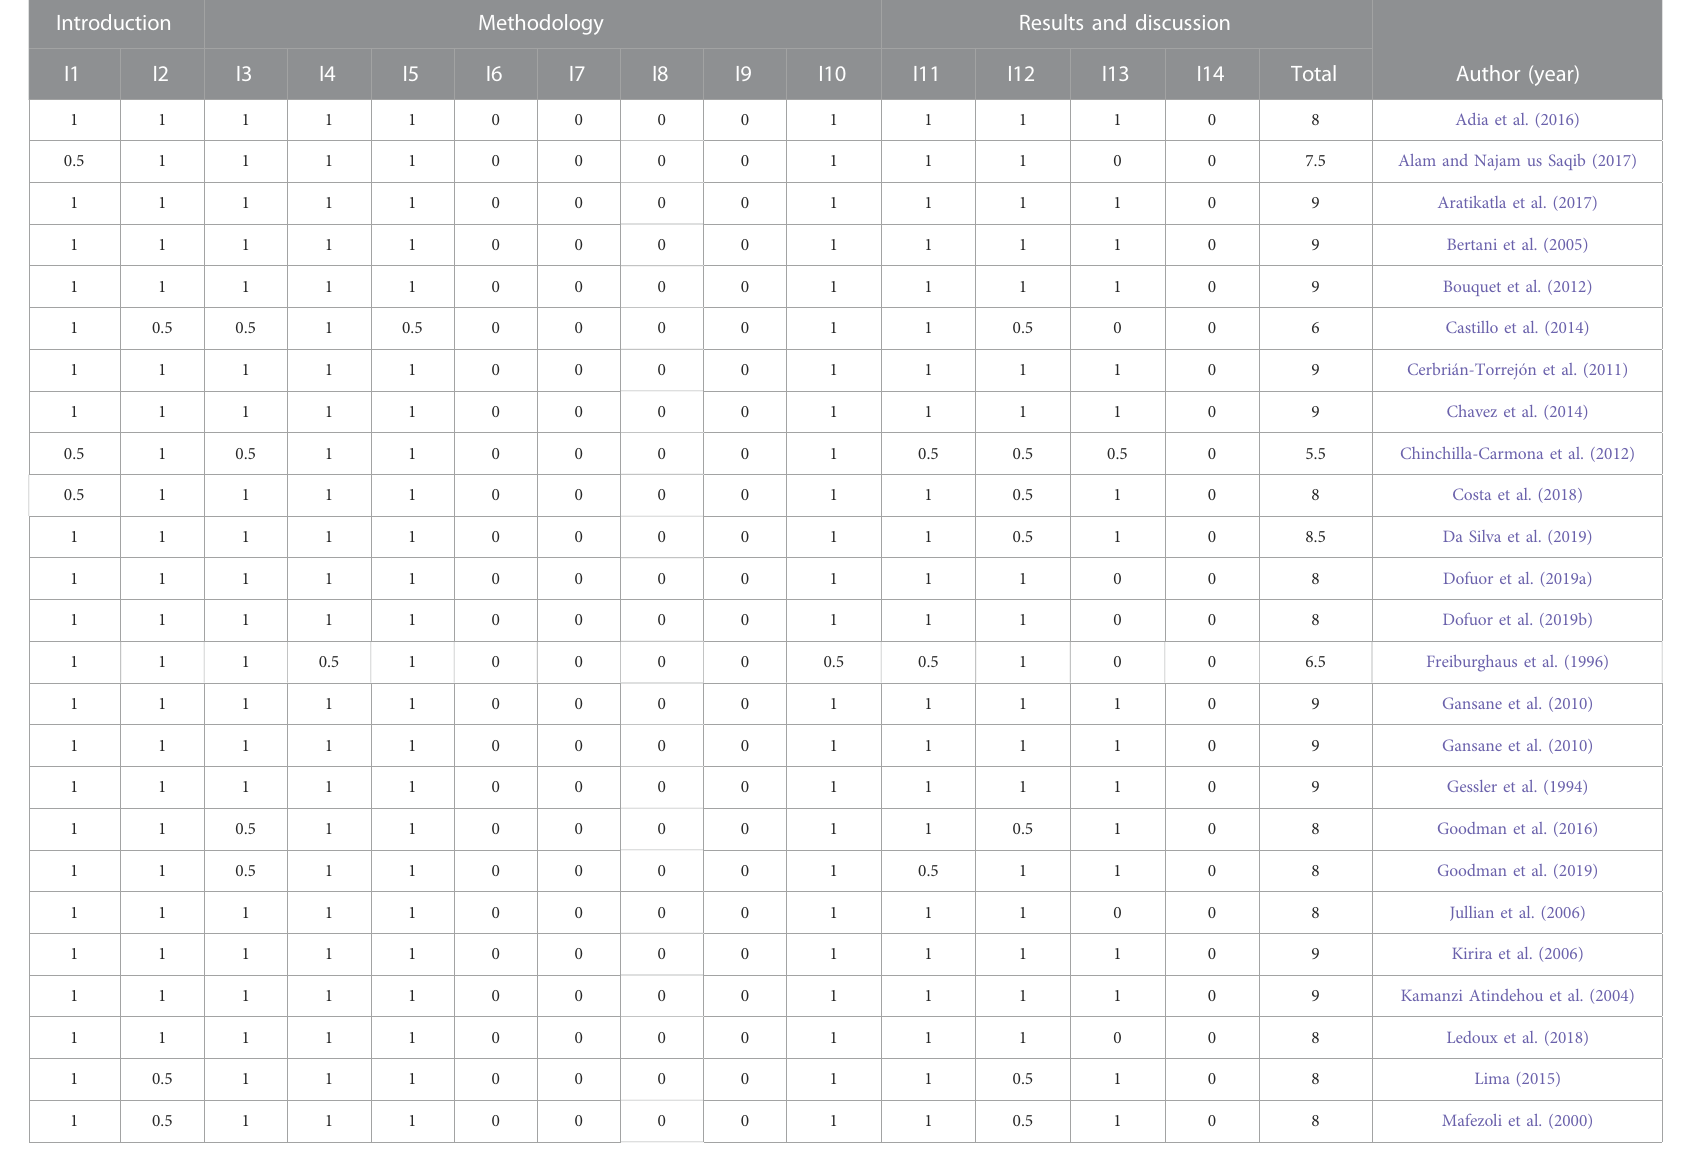
TABLE 1 Results of in vitro study